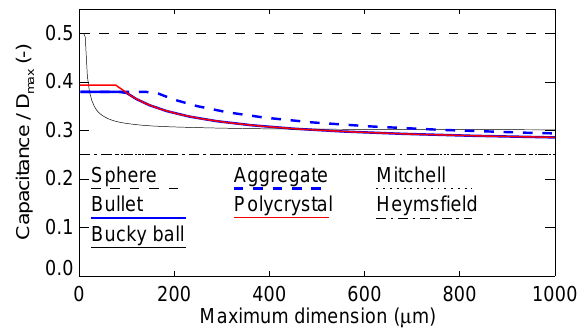
Figure 15. Ice crystal capacitance normalized by maximum dimen- sion at 350 mb and 233K for derived ice properties as in Fig. 14. In the absence of specified α e for some or all crystal sizes, a constant value is taken for Mitchell et al. (1996) and Heymsfield et al. (2002) ice properties (see text).